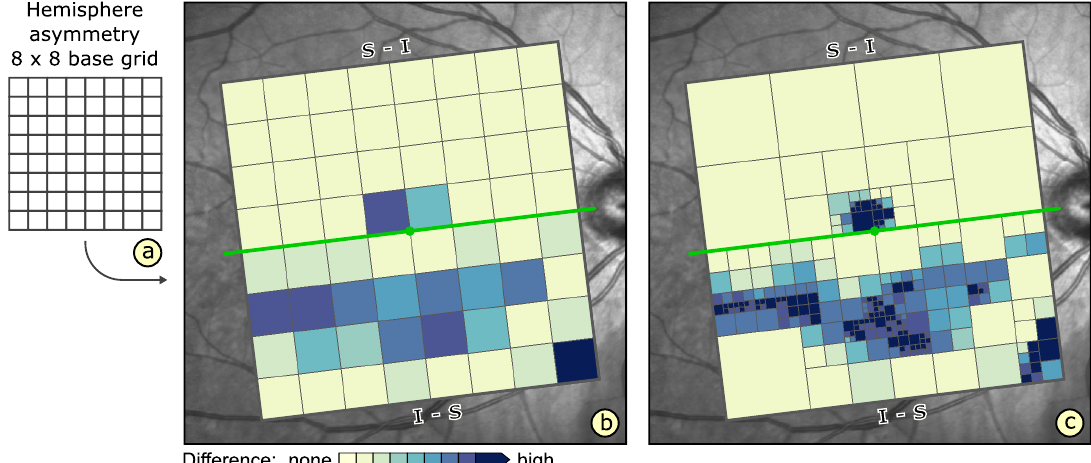
Figure 12. Asymmetry analysis of retinal layer thickness using rectangular grids. A standard 8 × 8 base grid layout ( a ) shows the mean difference between corresponding cells of opposite hemispheres ( b ). The fovea-to-disc axis (green line) marks the symmetry line and cell color encodes the degree of asymmetry (darker colors represent higher differences). In the upper grid half, negative differences between superior and inferior hemisphere are displayed and vice versa in the lower grid half. The subdivided grid ( c ) shows additional information on the spatial distribution and degree of